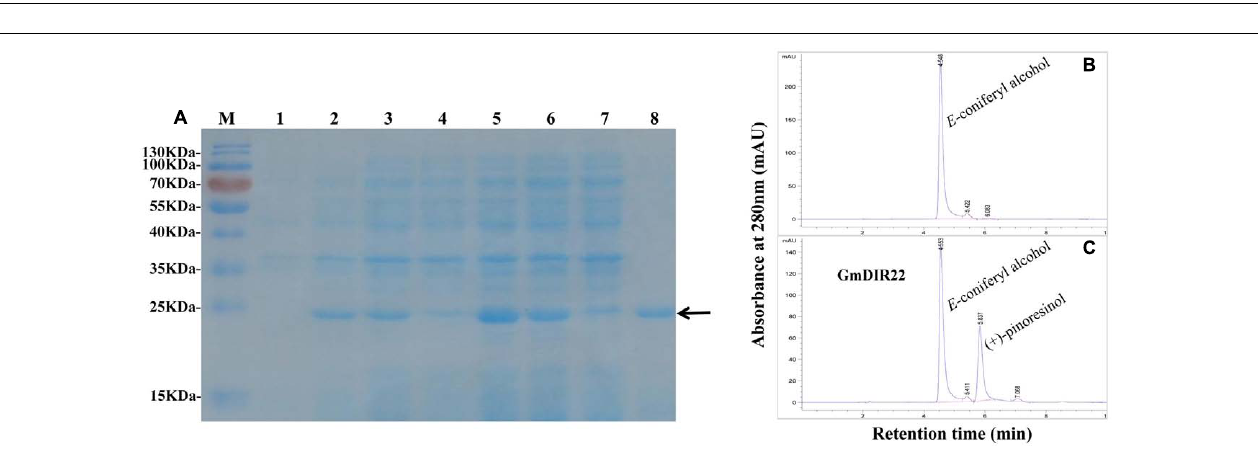
FIGURE 4 | Analysis of the subcellular localization of GmDIR22-GFP protein in Arabidopsis protoplasts. GmDIR22-GFP fusion protein expression was driven by the cauliflower mosaic virus 35S promoter and transiently expressed in Arabidopsis protoplasts. Bright-field images (A,E) , GFP fluorescence (green) only (B,F) , chlorophyll autofluorescence (red) only (C,G) , cytoplasmic marker fluorescence localization, and combined images (D,H) are shown. Bars = 10 µ m.